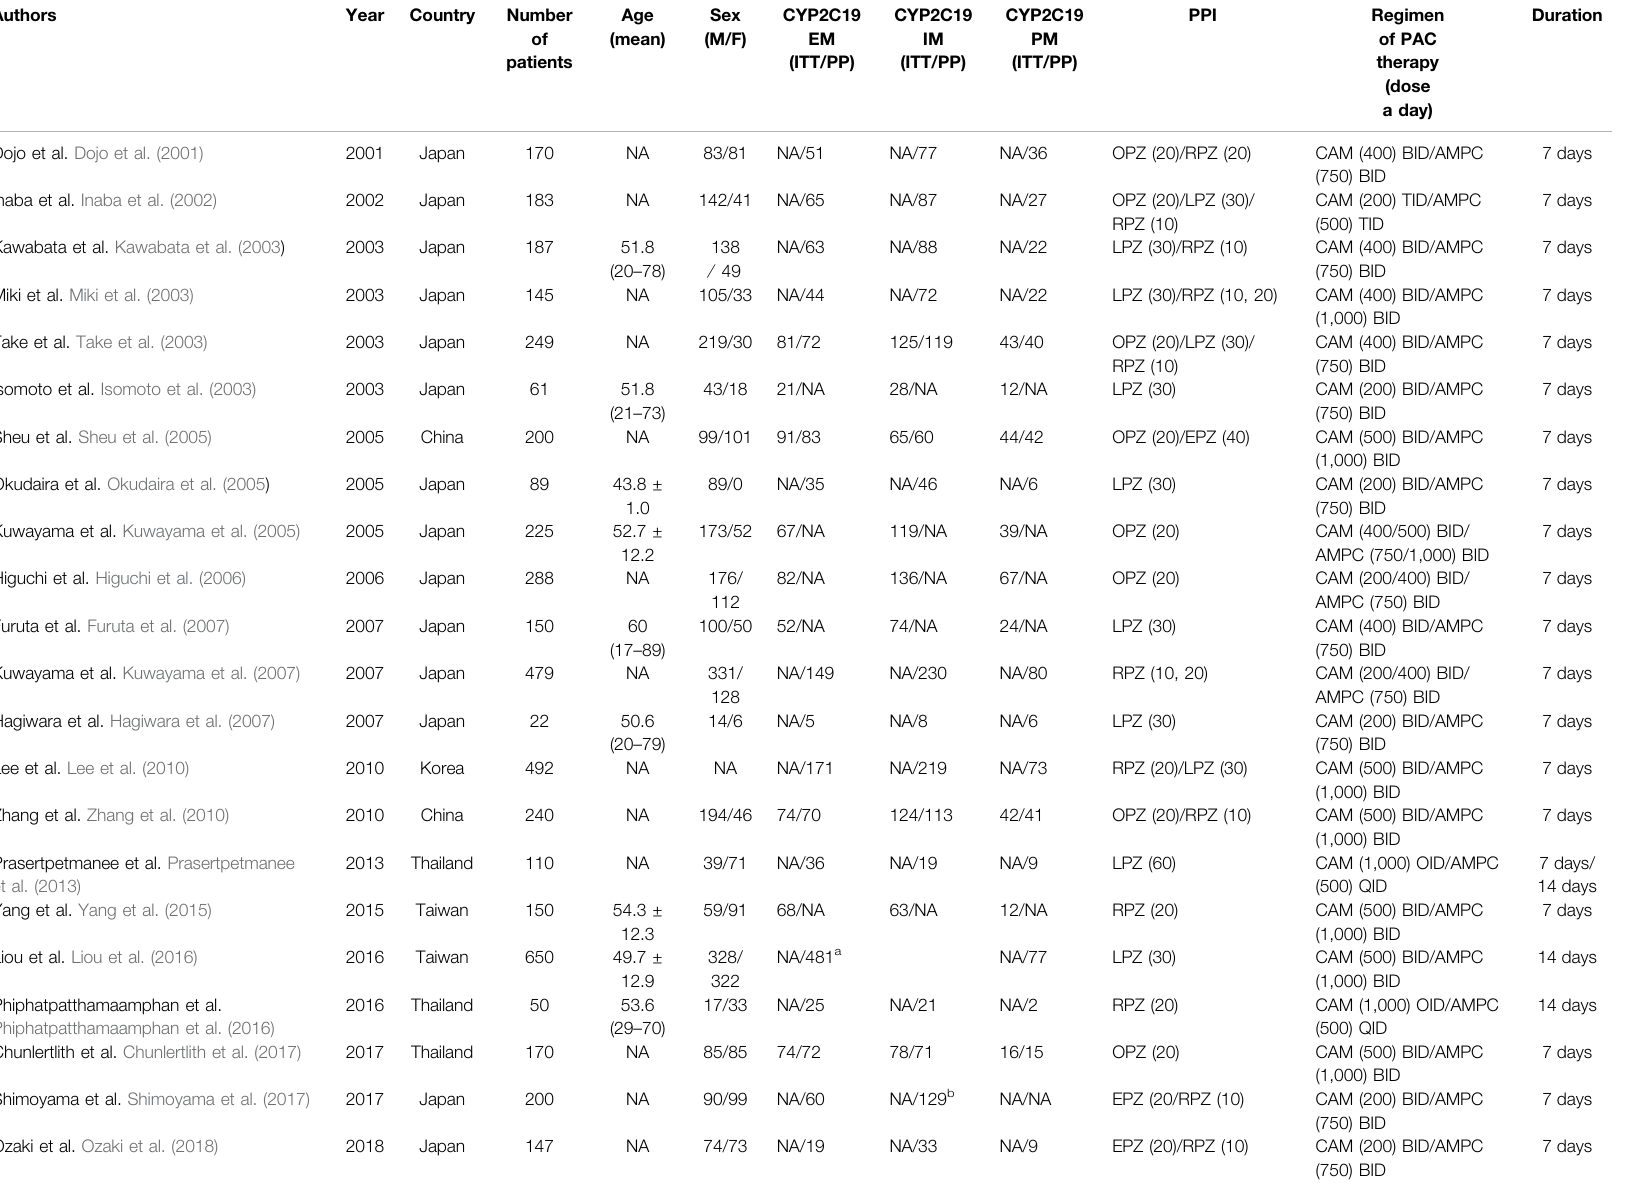
TABLE 1 | Characteristics of studies that investigated the H. pylori eradication outcome among CYP2C19 genotypes.